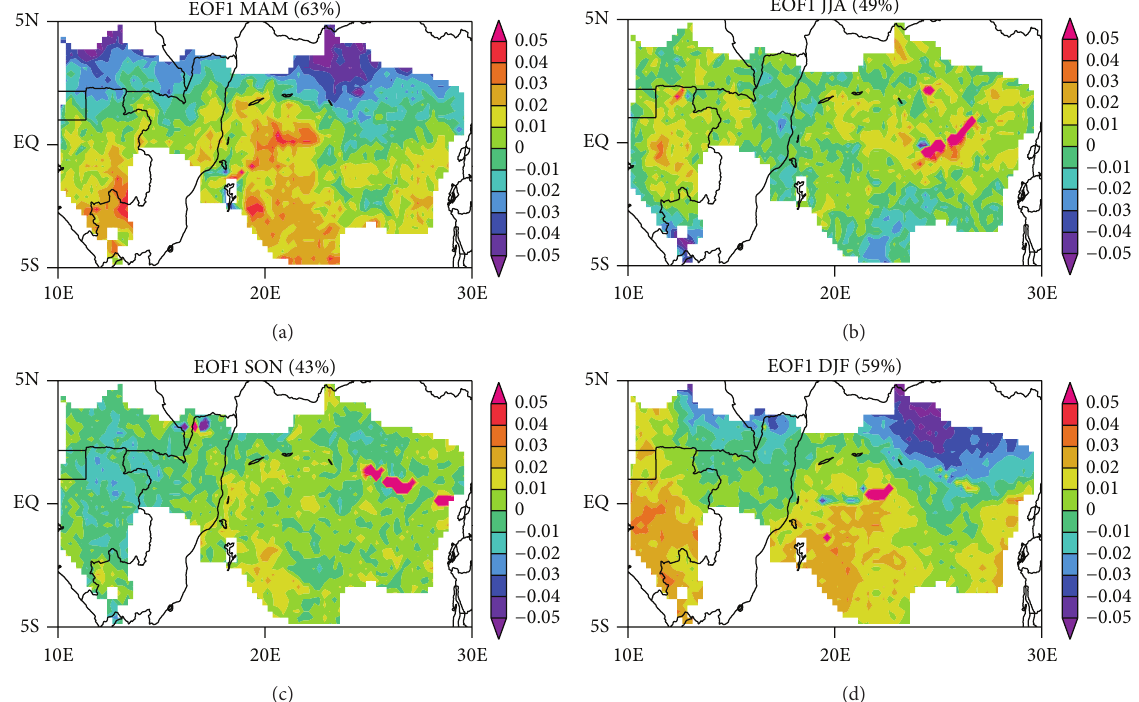
Figure 10: First EOF of the remotely sensed LST anomalies at 6:30 a.m. over Congo rainforests for the following seasons: (a) MAM, (b) JJA, (c) SON, and (d)